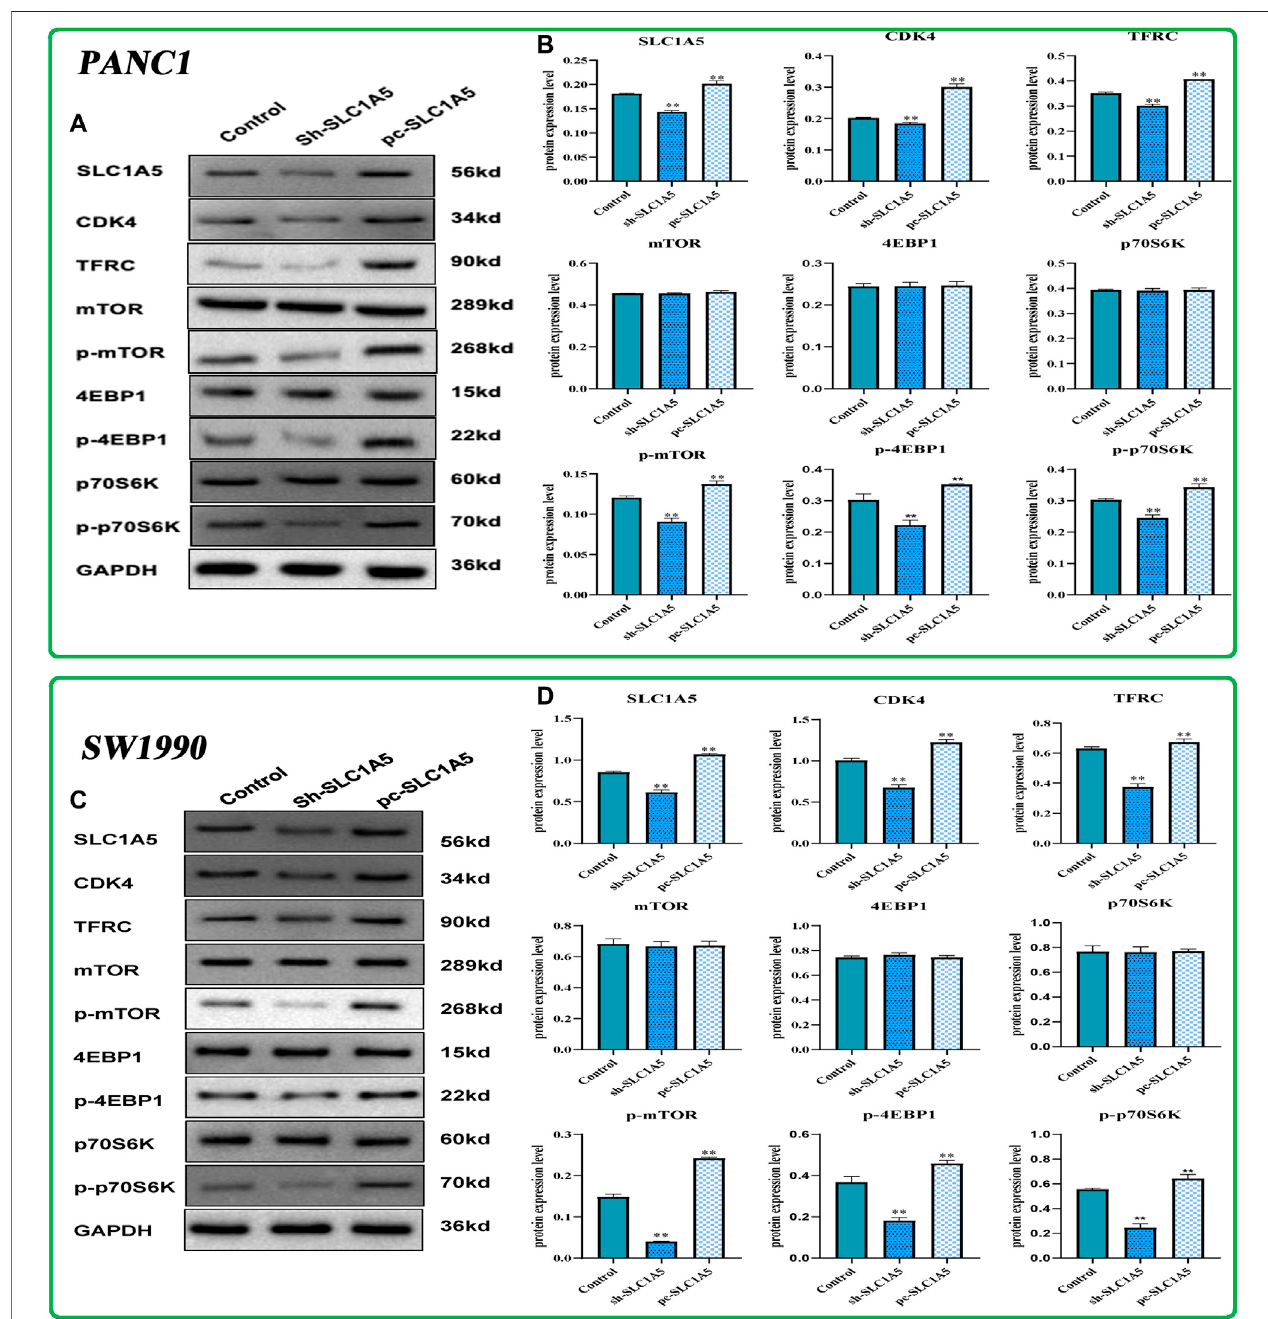
FIGURE9 | The effects ofSLC1A5on themTORC1signaling pathway, cell cycle,and ferroptosis basedon Westernblot tests. (A,B) The differences inthe protein expression of core molecules between silencing SLC1A5 and overexpression of SLC1A5 in the PANC-1 cells. (C,D ) The differences in the protein expression of core molecules between silencing SLC1A5 and overexpression of SLC1A5 in the SW1990 cells. * p < 0.05, ** p < 0.01, and *** p < 0.001.